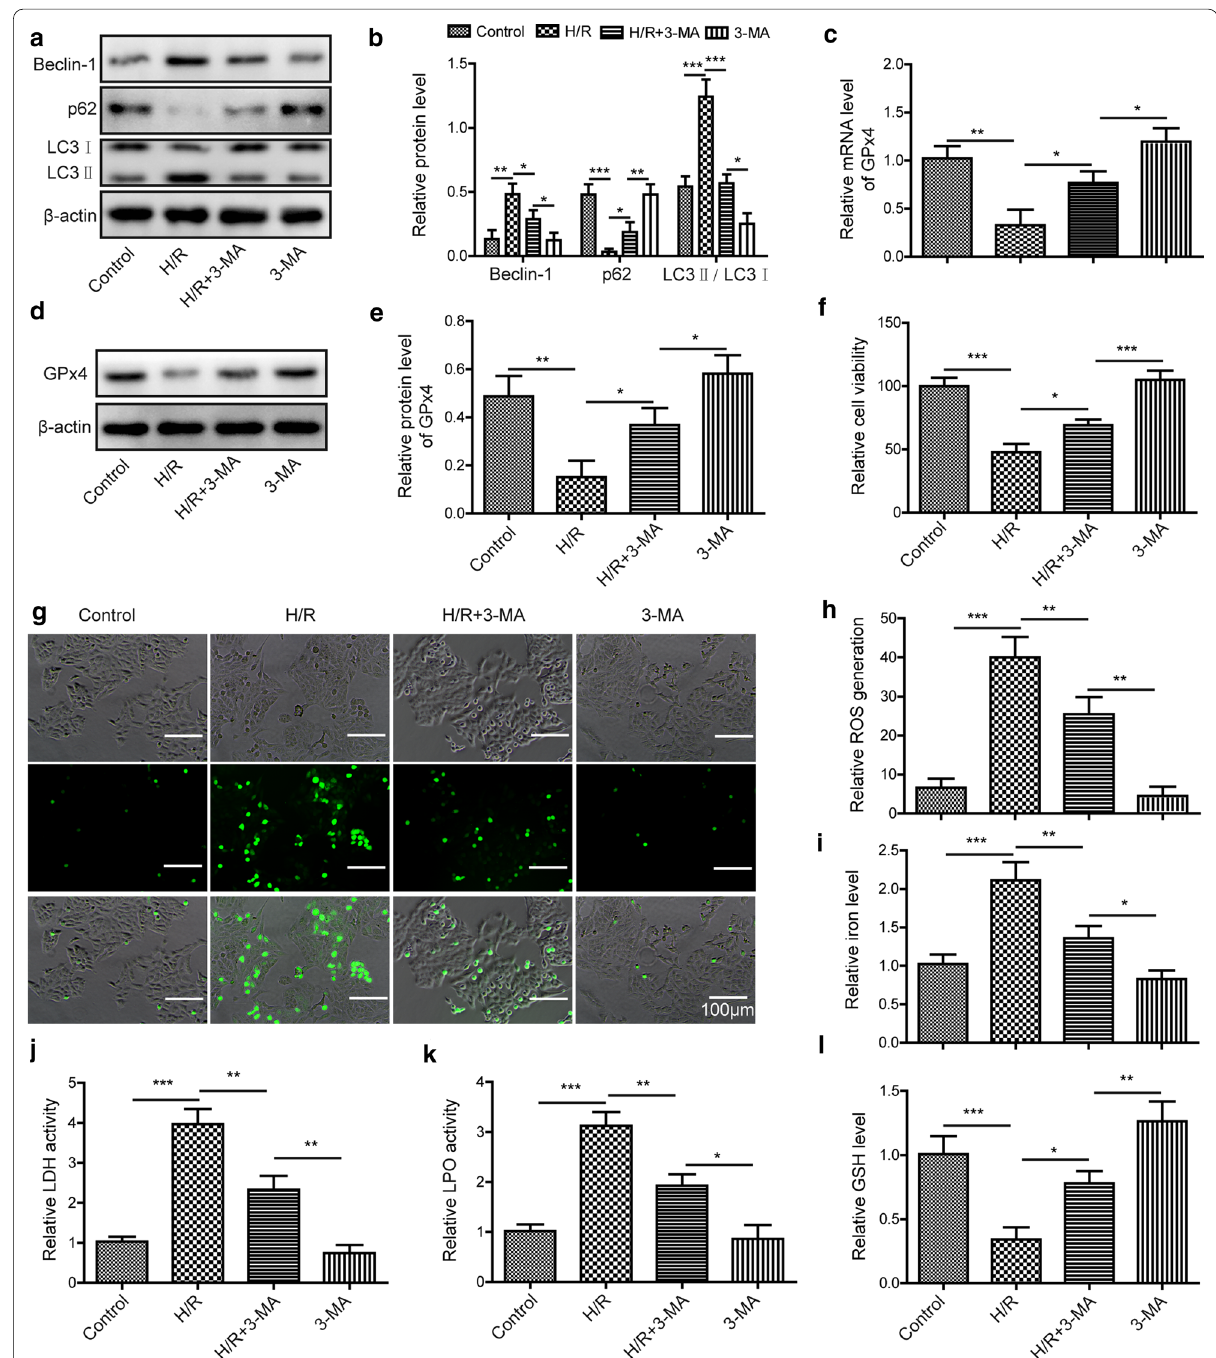
Fig. 4 Inhibition of autophagy suppresses H/R induced ferroptosis and cell injury. Myocardial cells were pretreated with 3‑MA (5 mM) for 24 h before being subjected to H/R. a , b Relative protein levels of Beclin‑1, p62 and LC3 were determined by western blotting. c – e Relative mRNA and protein levels of GPx4 in cells were assessed respectively. g CCK8 assay was performed to assess cell viability. (G&H) Relative cellular ROS levels in 3‑MA treated cells were measured after H/R. Relative cellular iron level ( i ), LDH activity ( j ), LPO level ( k ) and GSH level ( l ) in each group of cells were detected by corresponding assay kits after H/R. The results were presented as the mean